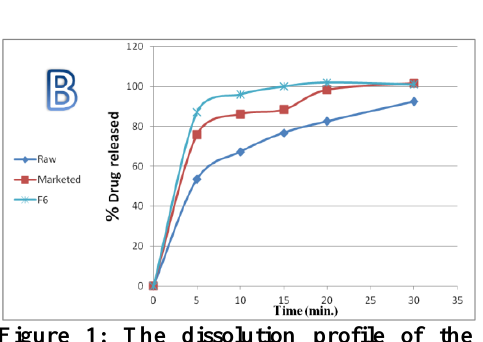
Figure 1: The dissolution profile of the selected formula (F6) at 37ºC ± 0.5 ºC and 50 rpm. A: in 0.1N HCl +0.1% methanol media.B: In phosphate buffer pH(7.2)